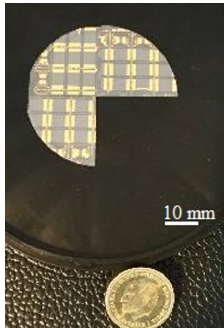
Figure 1. Processed epitaxial graphene on silicon carbide (EG-SiC) wafer with graphene-based devices and different test